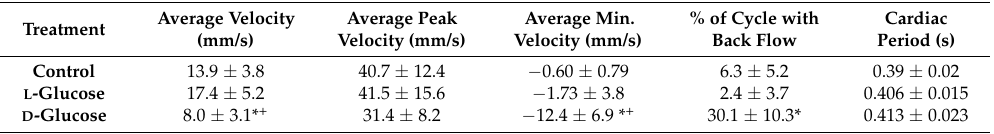
Table 3. Hemodynamic parameters for each